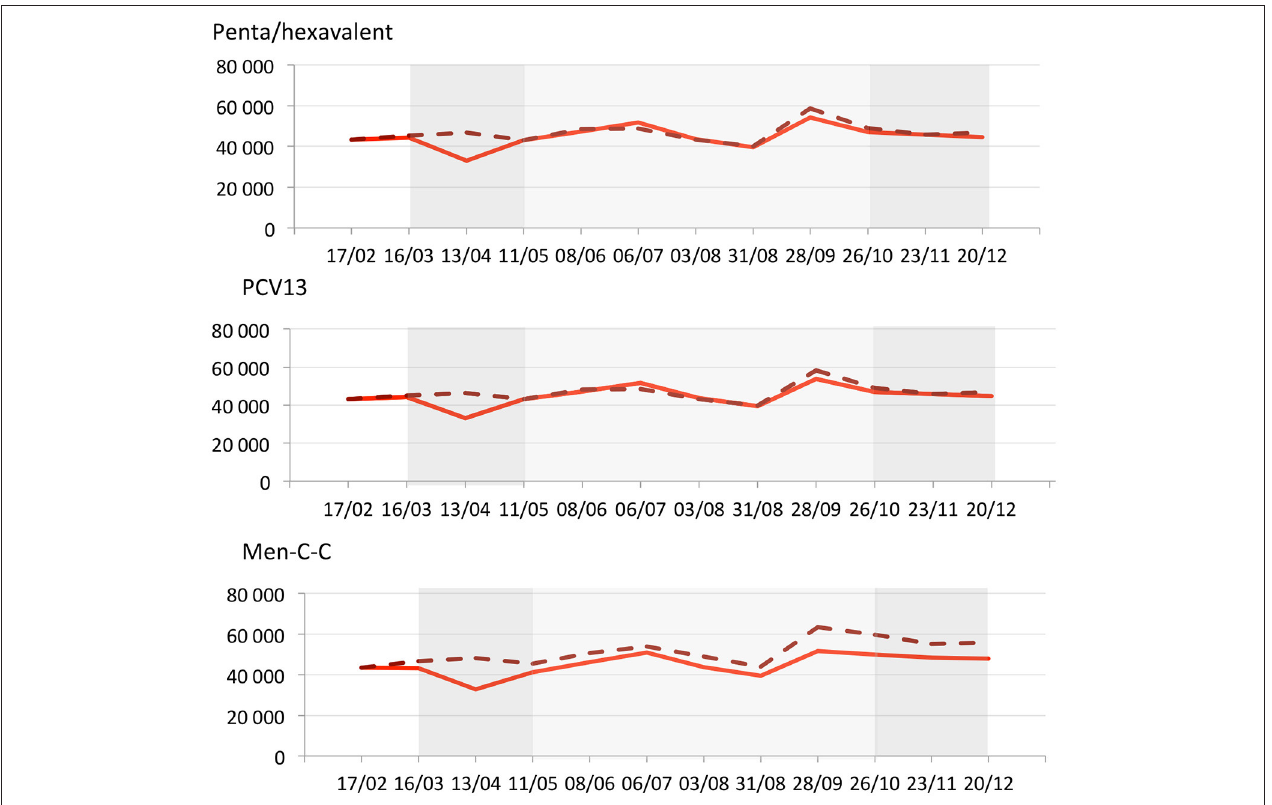
FIGURE 2 | Observed (solid red line) and expected (dashed red line) weekly counts for booster dispensations of penta/hexavalent, 13-valent-pneumococcal conjugate (PCV13), meningococcal-conjugate type-C (Men-C-C) and measles mumps rubella (MMR} in France (from January 20 to December 20, 2020). Dark gray rectangles illustrate the first and the second lockdowns (from 16/03 to 10/05 and from 30/10 to 15/12, respectively). Light gray rectangle illustrates the inter-lockdown period (11/05 to 29/10). The X-axis is in 4-week periods since the beginning of 2020. The Y axis represents the number of dispensed boosters over the 4 previous weeks at each time